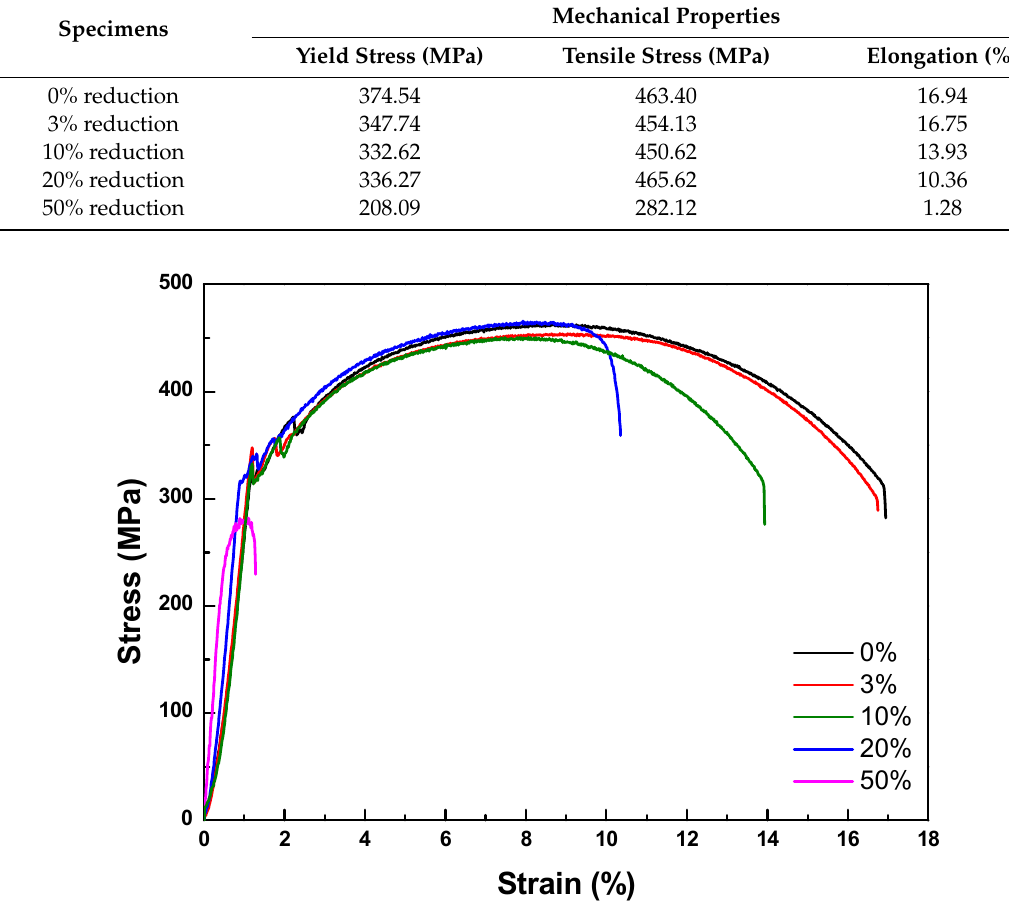
Figure 9. Stress–strain curves of accelerated corrosion specimens.